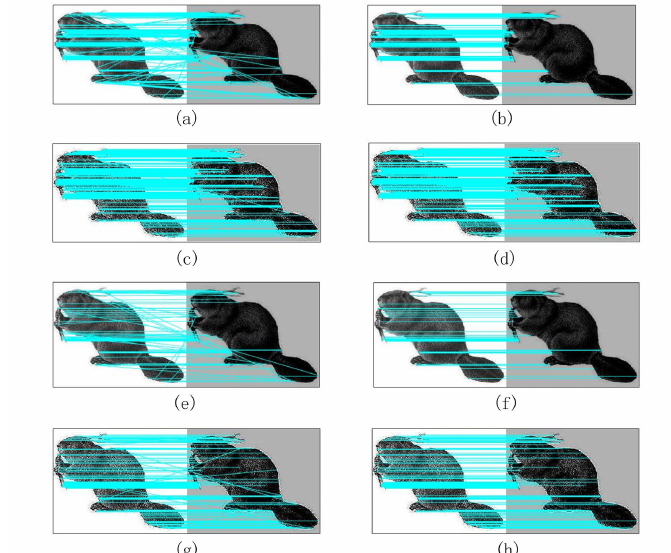
Figure 10. ( a , b ) show graph matching without Laplace filter before and after RANSAC optimization; ( c , d ) show graph matching under Laplace filter before and after RANSAC optimization; ( e , f ) show graph matching using entropy algorithm without Laplace filter before and after RANSAC optimization; ( g , h ) show graph matching using entropy algorithm under Laplace filter before and after RANSAC